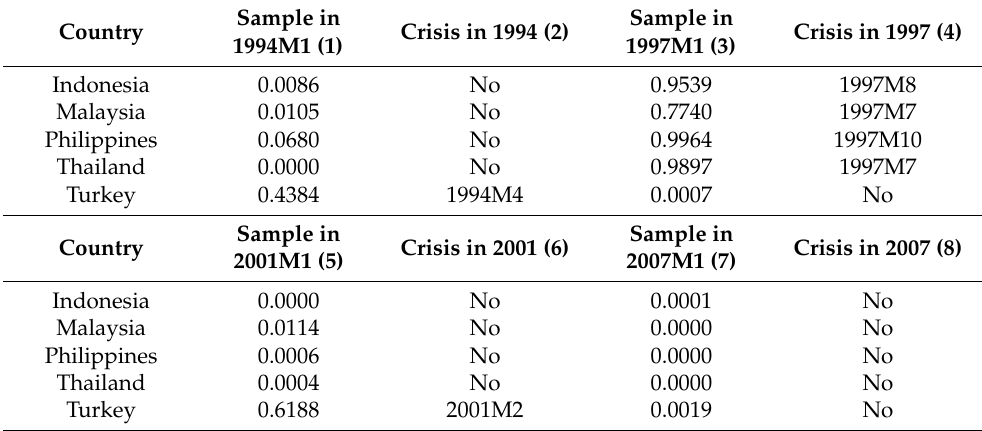
Table 8. Emerging countries in 1994, 1997, 2001, and